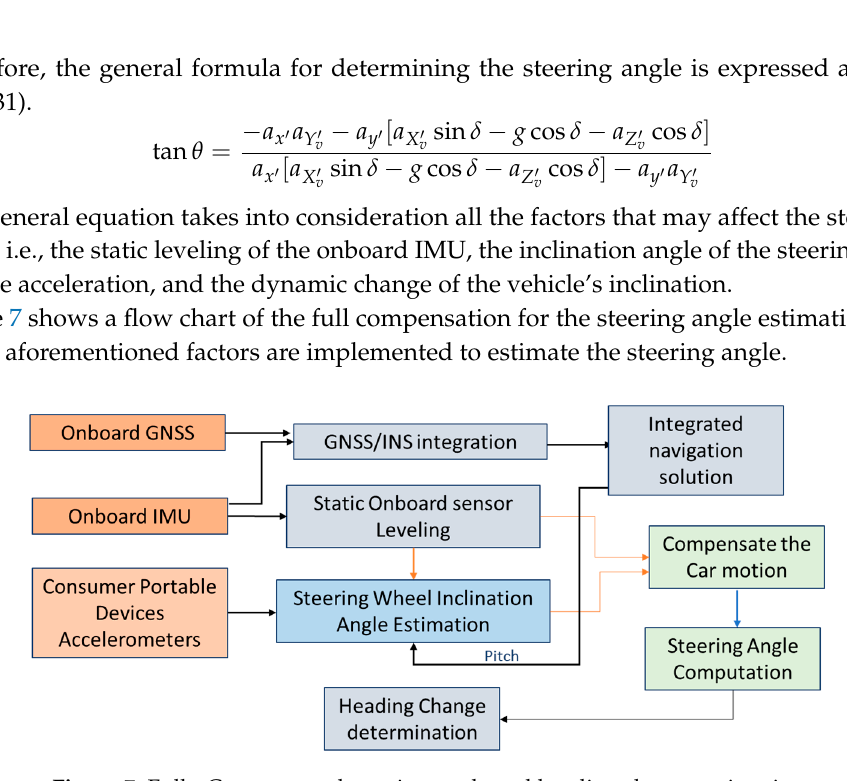
Figure 7. Fully-Compensated steering angle and heading change estimation.